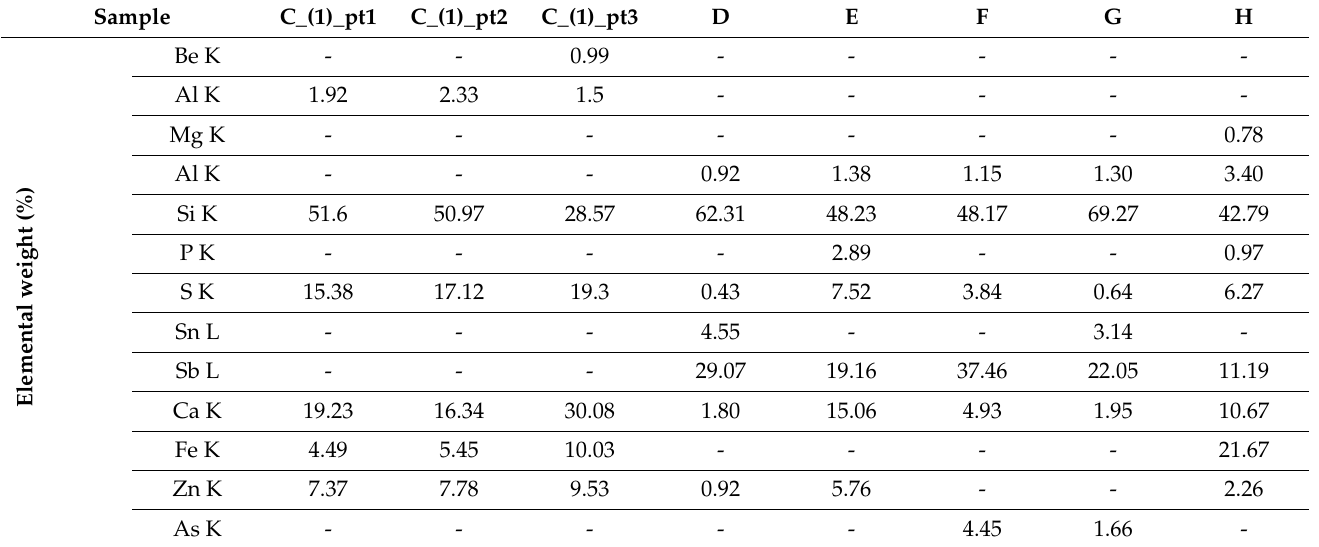
Table 3. Chemical composition of extreme layers of deposits from piston from different landfills (landfill C, and average composition for landfills D–H), weight share